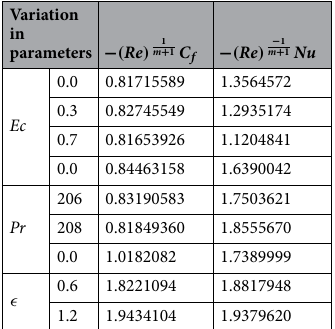
Table 5. Thermal aspects of Nusselt number and skin friction coefficient versus Ec , Pr and ǫ